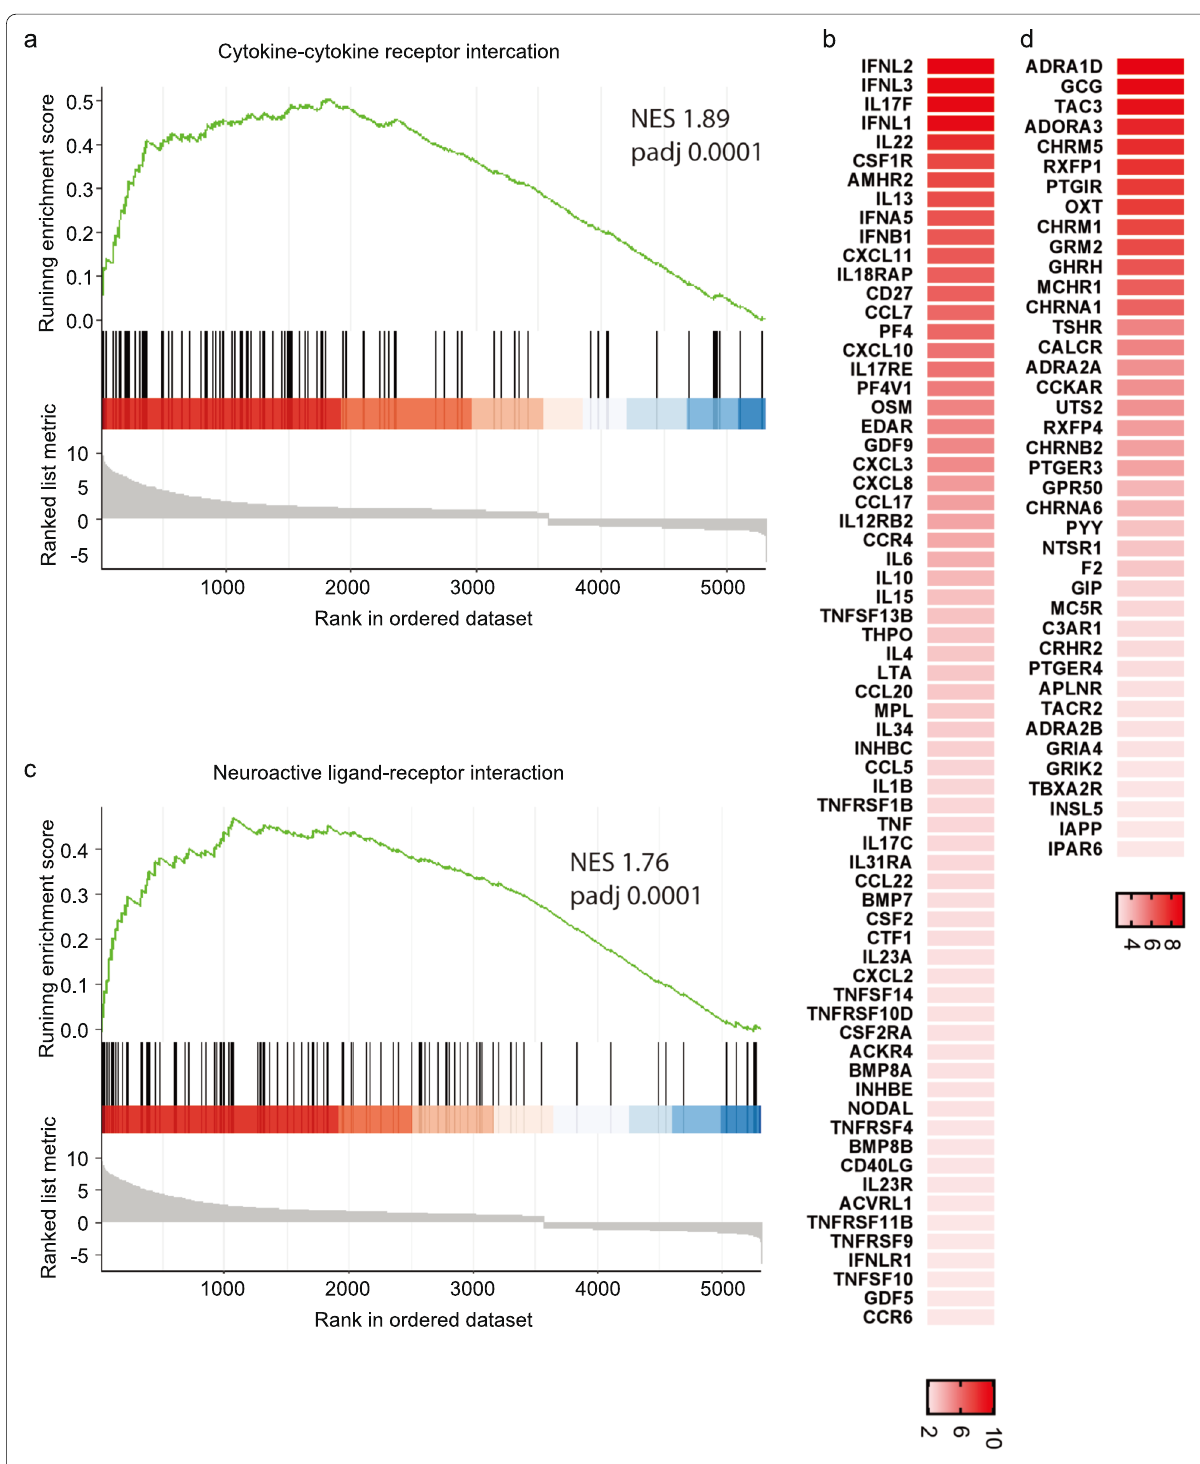
Fig. 8 GSEA plots of enriched KEGG pathways. a GSEA plots indicating the running enrichment score for gene expression signature of ‘cytokine-cytokine receptor interaction’ (NES 1.89, padj 0.0001), and its associated top up-regaulted genes ( b ) visualized in a heatmap, in addition to the GSEA plot for = = the ( c ) ‘neuroactive ligand-receptor interaction’ pathway (NES 1.76, padj 0.0001) and its associated top activated genes ( d ). Black bars underneath the = = graph present the rank positions of genes from the gene set, the green line refers to the enrichment profile. GO, KEGG and GSEA were performed by the R package clusterProfiler; R package DOSE; R package org.HS.eg.db. and visualized by the R package Enrichplot and R package